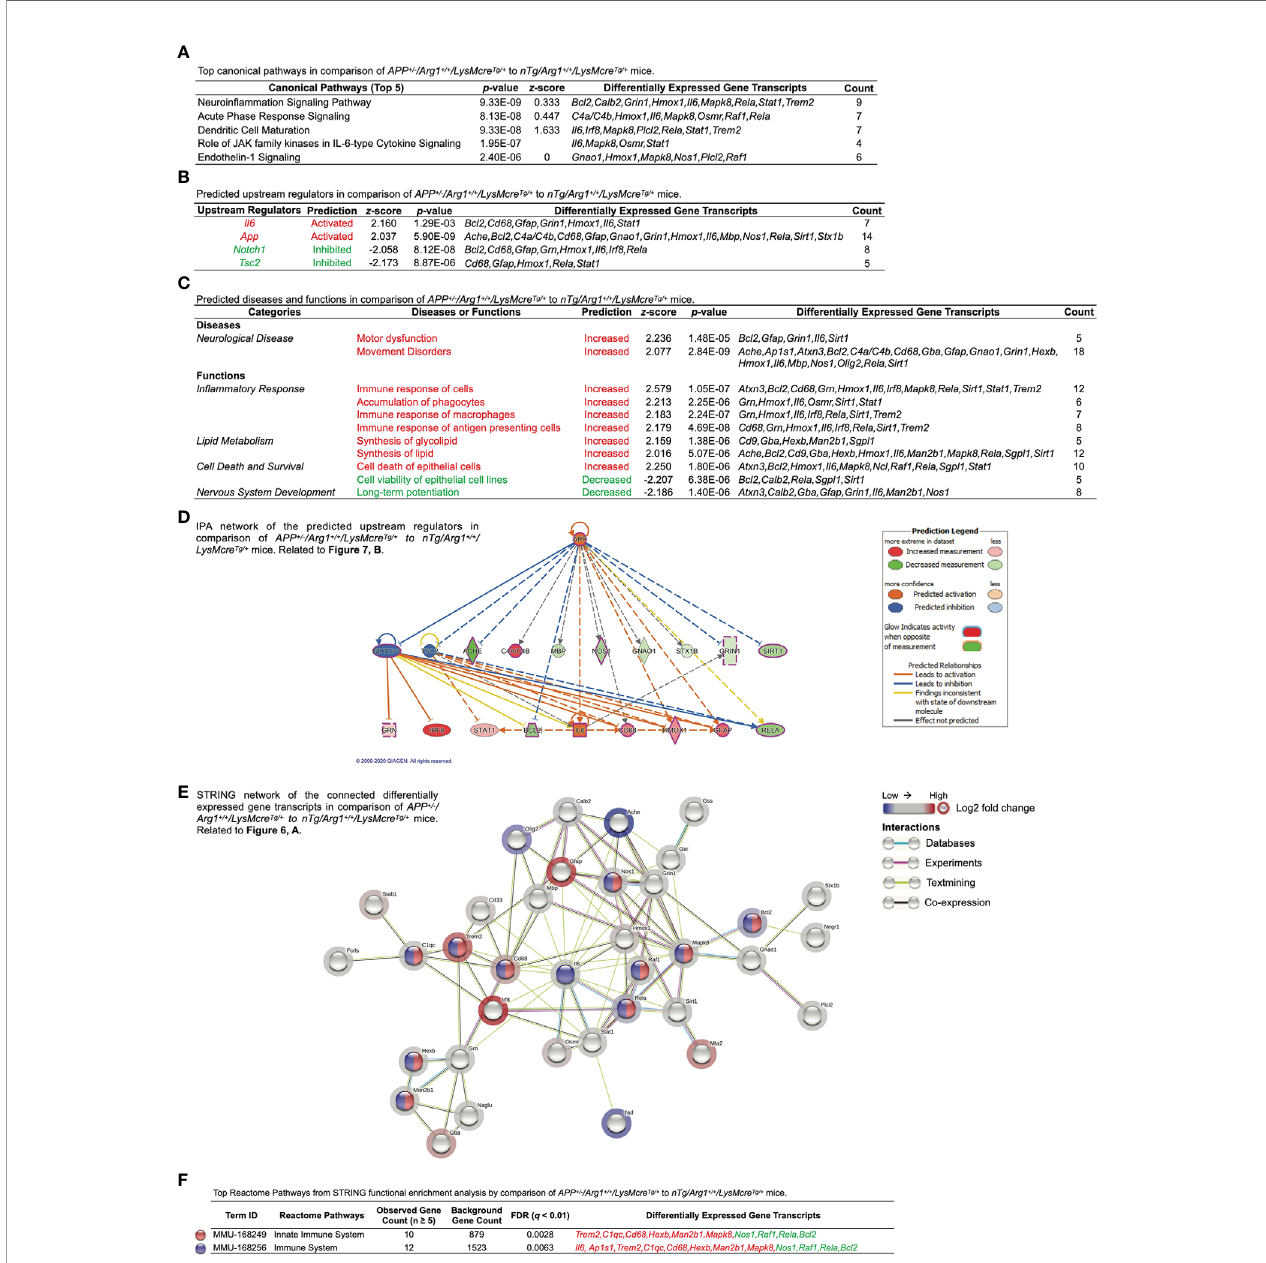
FIGURE 7 | Ingenuity Pathway Analysis and STRING network analysis of overexpressing human APP KM670/671NL Swedish mutation in mouse brain. Differentially expressed gene transcripts (DEGs, p < 0.05) created by comparing APP +/- /Arg1 +/+ /LysMcre Tg/+ to nTg/Arg1 +/+ /LysMcre Tg/+ mice were analyzed by Ingenuity Pathway Analysis (IPA) and STRING network analysis using publicly available databases. (A) A table lists the top fi ve canonical pathways (based on p -values). (B) A table lists the top predicted upstream regulators (based on z -scores). (C) A table lists the top predicted diseases and functions under different categories (based on z -scores). An absolute z -score value at 2.0 was set as the cut-off criterion to predict the activated/increased ( z -score > 0) or inhibited/decreased ( z -score < 0) states, and were highlighted in red or green. (D) IPA network displays the predicted upstream regulators in a hierarchical order. Upstream regulators predicted as activation or inhibition are colored in orange or blue. DEGs are colored in red or green, indicating increased or decreased expression. DEGs involved in Alzheimer ’ s disease are also highlighted with a purple border. Direct or indirect gene interactions are in solid or dash lines with orange or blue colors indicating activation or inhibition. The intensity of color shading represents either measured fold-change magnitude or predicted activation/inhibition magnitude. (E) STRING network of the connected DEGs is presented. Each node represents a DEG with a halo color of red to blue, indicating high to low values of log2 fold-change. Nodes in different colors are annotated based on the top Reactome Pathways. Each edge line represents an interaction between two DEGs based on parameters of databases (cyan), experiments (purple), textmining (yellow), and co-expression (black). (F) A table lists the top Reactome Pathways from STRING functional enrichment analysis. The false discovery rate (FDR) q -value is set at ≤ 0.01. The observed gene count is set at ≥ 5. DEGs highlighted in red or green indicate up or down expression. n=3 samples per group representing 6